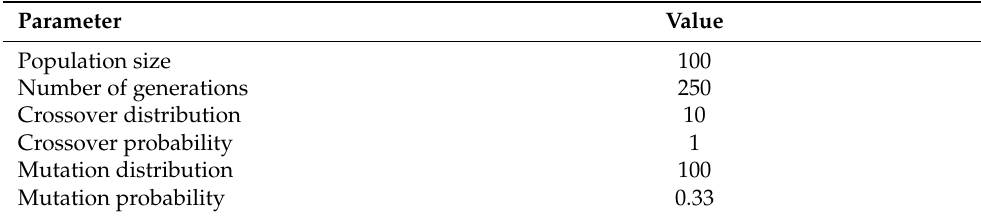
Table 4. NSGA-II Table 4. NSGA-II parameters.